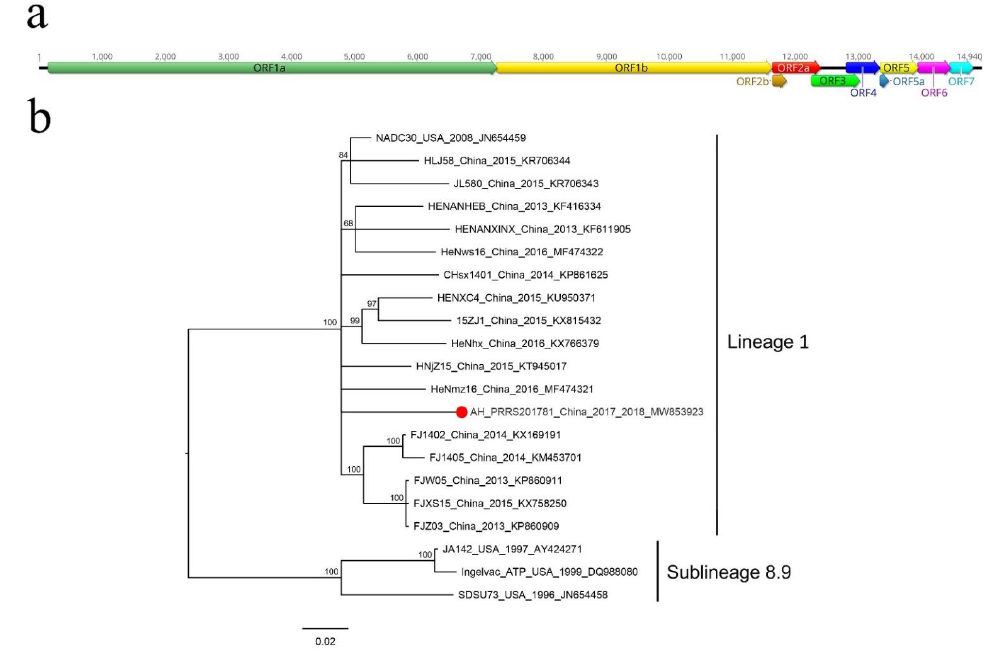
Figure 3. Porcine reproductive and respiratory syndrome virus isolated from sick pig: (a) genomic organization of AH-PRRS20178-1, including the ORFs and the viral protein encoding sequences; (b) phylogenetic analysis based on the ORF5 sequences of AH-PRRS20178-1 and reference strains of another type-2 PRRSV. AH-PRRS20178-1 identified in this study is marked with solid red circle.